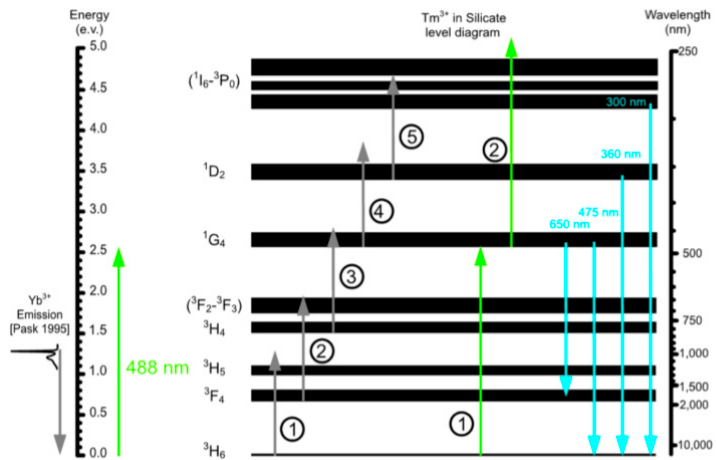
Figure 2. ( a ). possible photon avalanche upconversion process in Tm-doped silica. ( b ). proposed energy transfer upconversion process in Tm-doped silica.